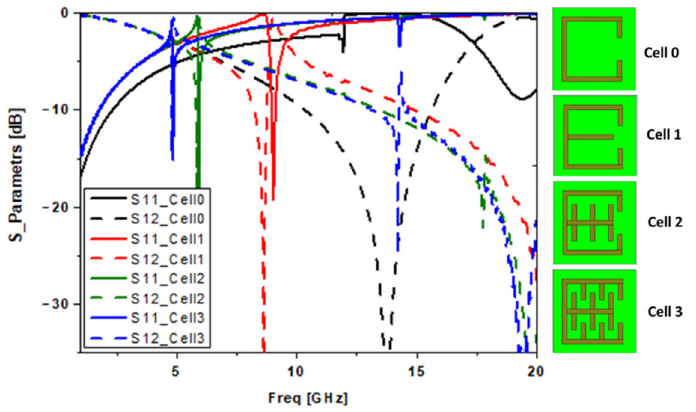
Figure 6. Curve of the reflection and transmission coefficients produced by different proposed struc- tures.